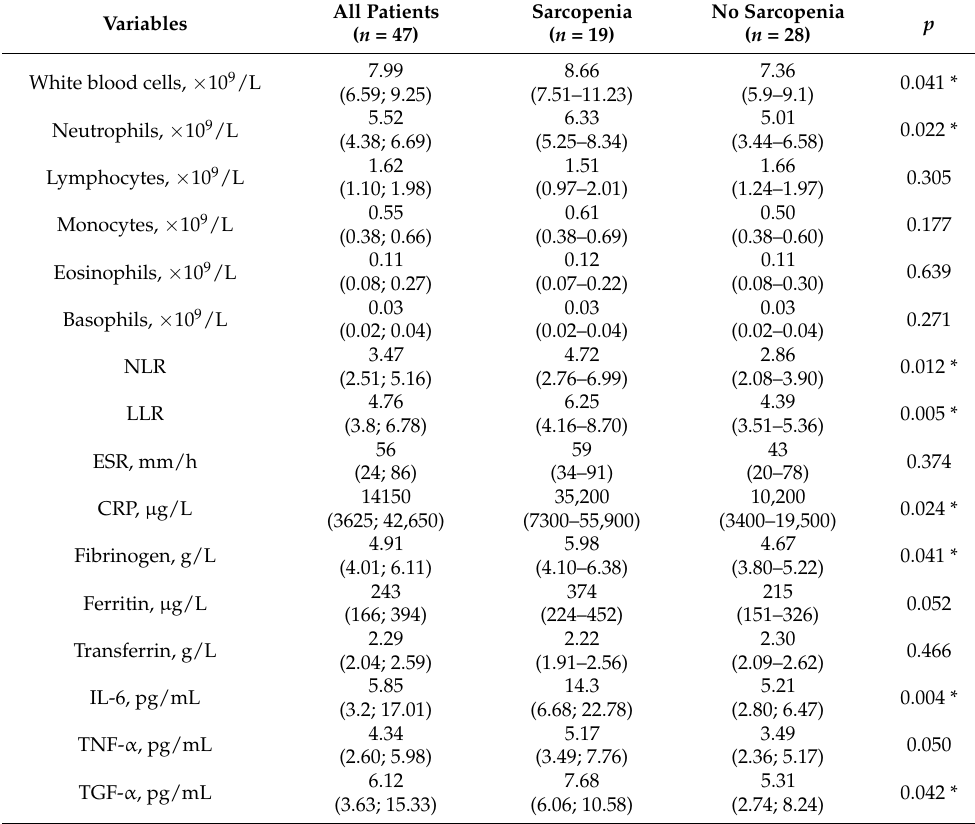
Table 4. Data on baseline full blood count, inflammatory parameters and cytokines comparing sarcopenic vs. non-sarcopenic groups. Mann-Whitney U test (* p <